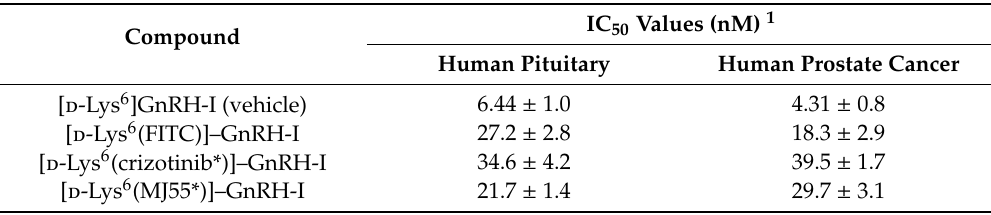
Table 1. Inhibition of [ 125 I]-[ d -Trp 6 ]–GnRH-I binding to the membranes of human pituitary and human prostate cancer cells by GnRH derivatives.